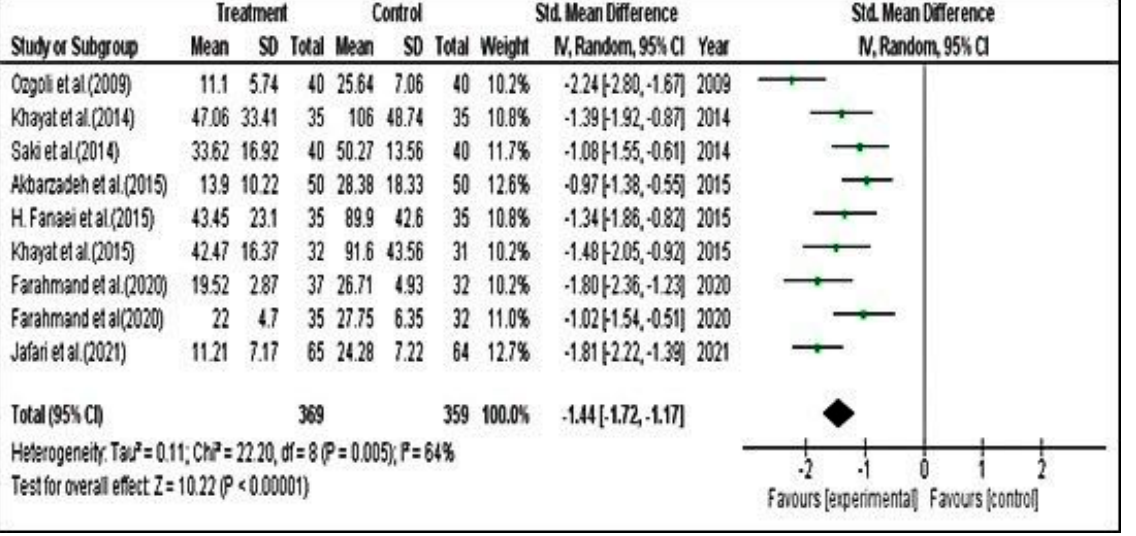
Figure 4. Forest plot for premenstrual screening tool (PSST) [5,7,45,47,49–51,54,55].